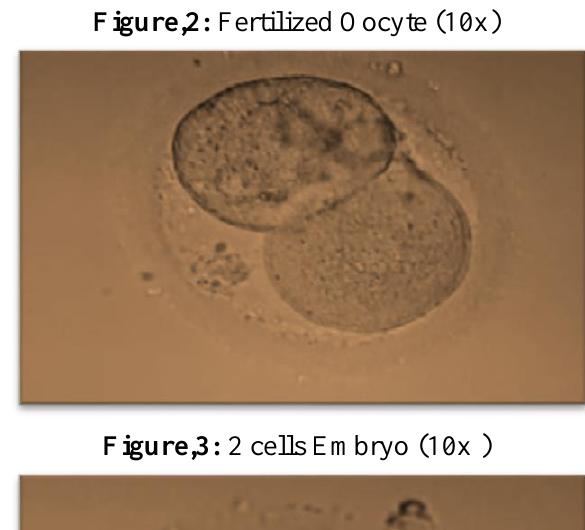
Figure,2: Fertilized Oocyte (10x)